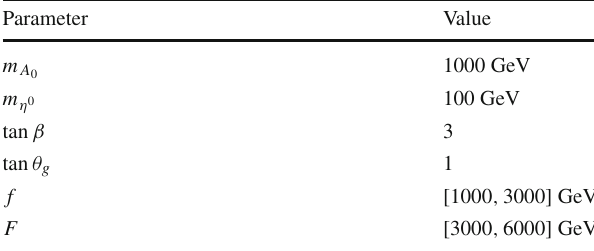
Table 3 Values assigned to the free parameters involved in our numer- ical analysis in the context of the BLHM Parameter Value m A